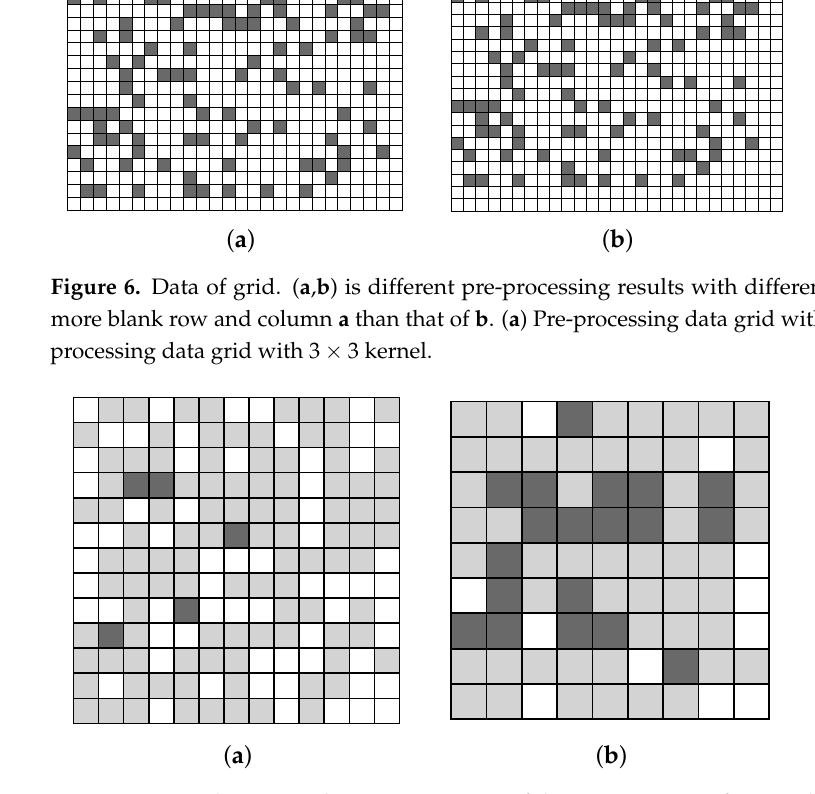
Figure 7. Convolution result matrix. Because of the various sizes of CKM, the number of row and column of result matrices is different. ( a ) Convolution result Matrix with 2 × 2 kernel. ( b ) Convolution result Matrix with 3 × 3